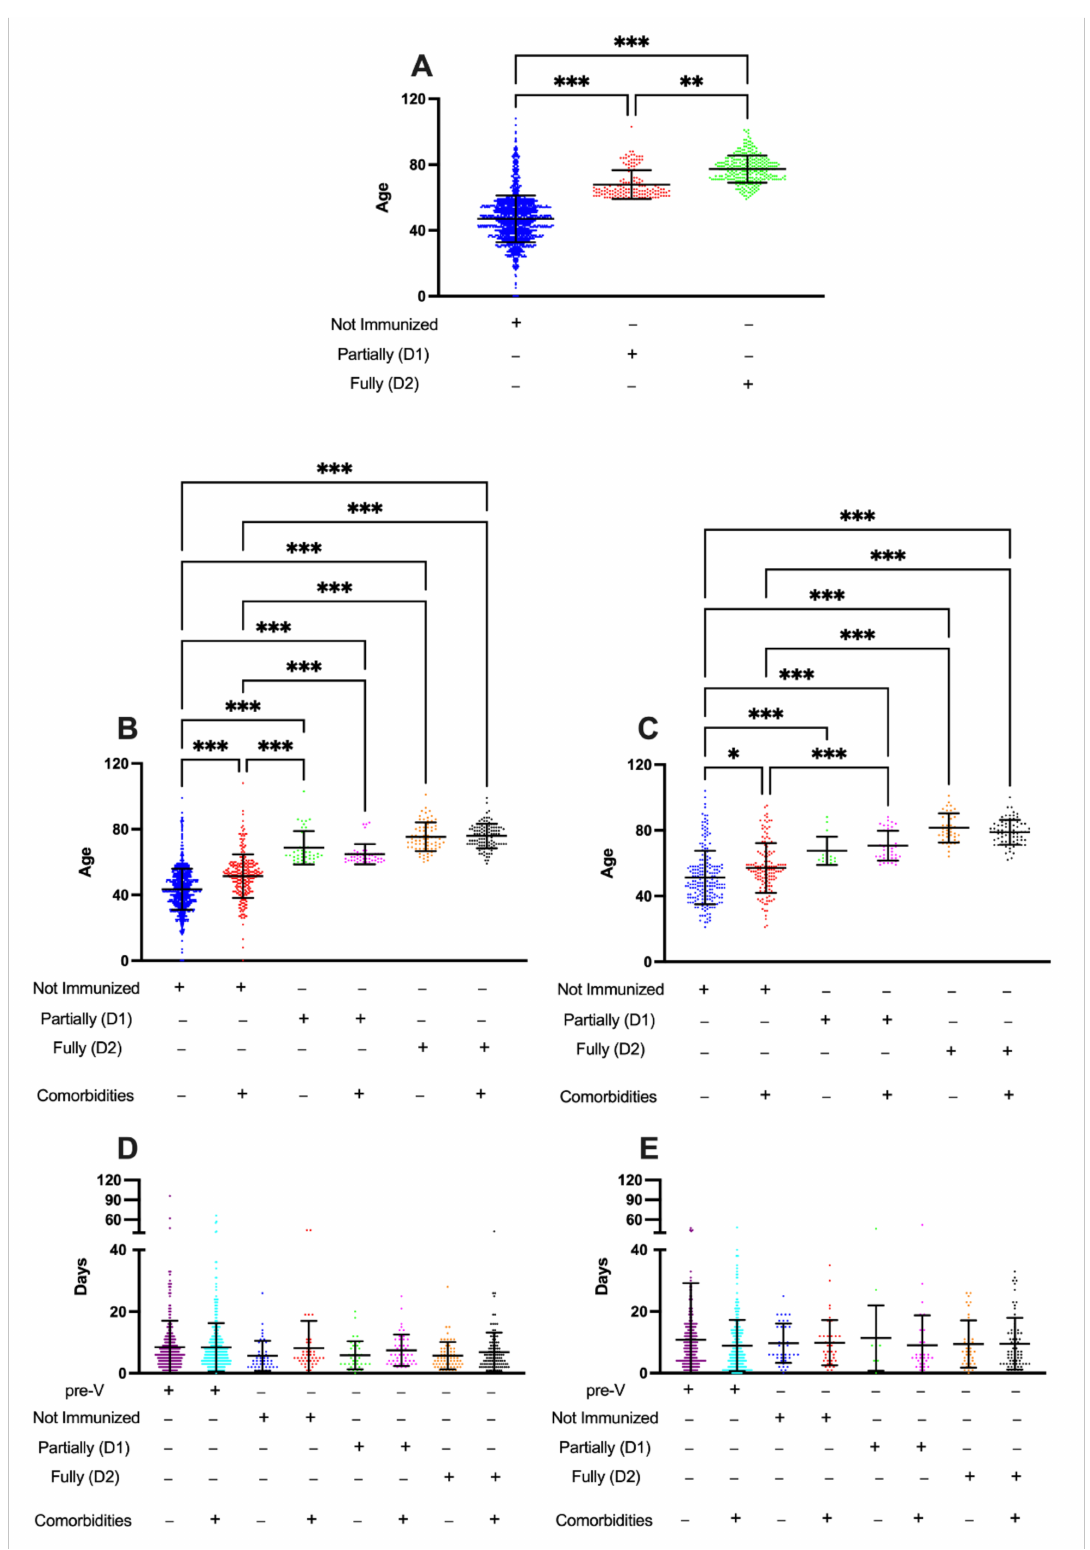
Figure 3. Profile of discharged patients and lethal outcomes related to COVID-19 before and after vaccination. Considering the pre-vaccination (June to August 2020, pre-V) and post-vaccination